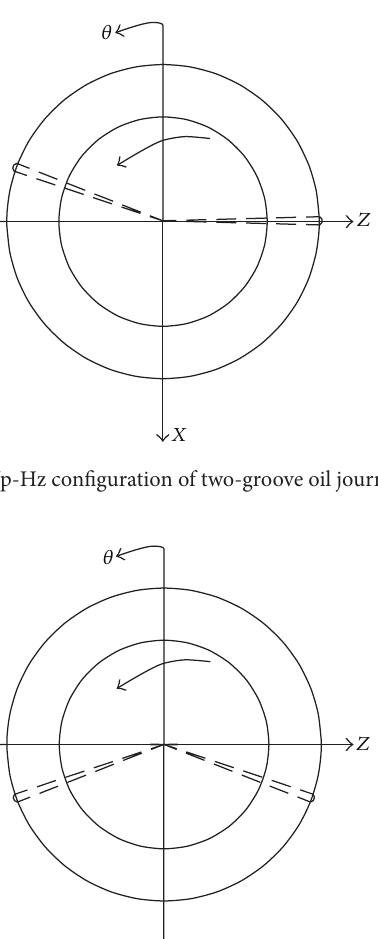
∘ interval (Figure 4). Up-10 Hz ∘ above